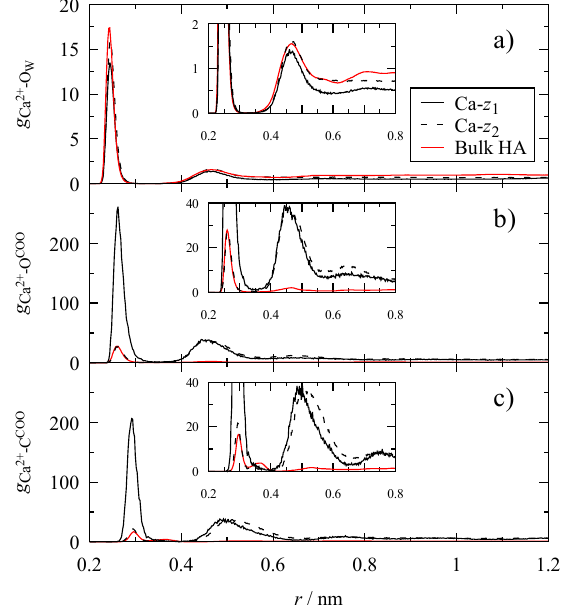
Figure 5. Radial distribution functions (RDFs; g ij ) of calcium (Ca 2+ ) with the water oxygen atoms ( a ), carboxylate oxygen ( b ), and carbon atoms ( c ) of humic acids on the aluminol side at distance r from the Ca 2+ confined in two regions–Ca–z 1 (0 < z 1 < 0.5 nm) and Ca–z 2 (0.5 < z 2 < 0.9 nm). Black lines correspond to RDFs in this work, whereas red lines to those observed for Ca 2+ in bulk HA matrix from Galicia–Andrés et al. [20], respectively.